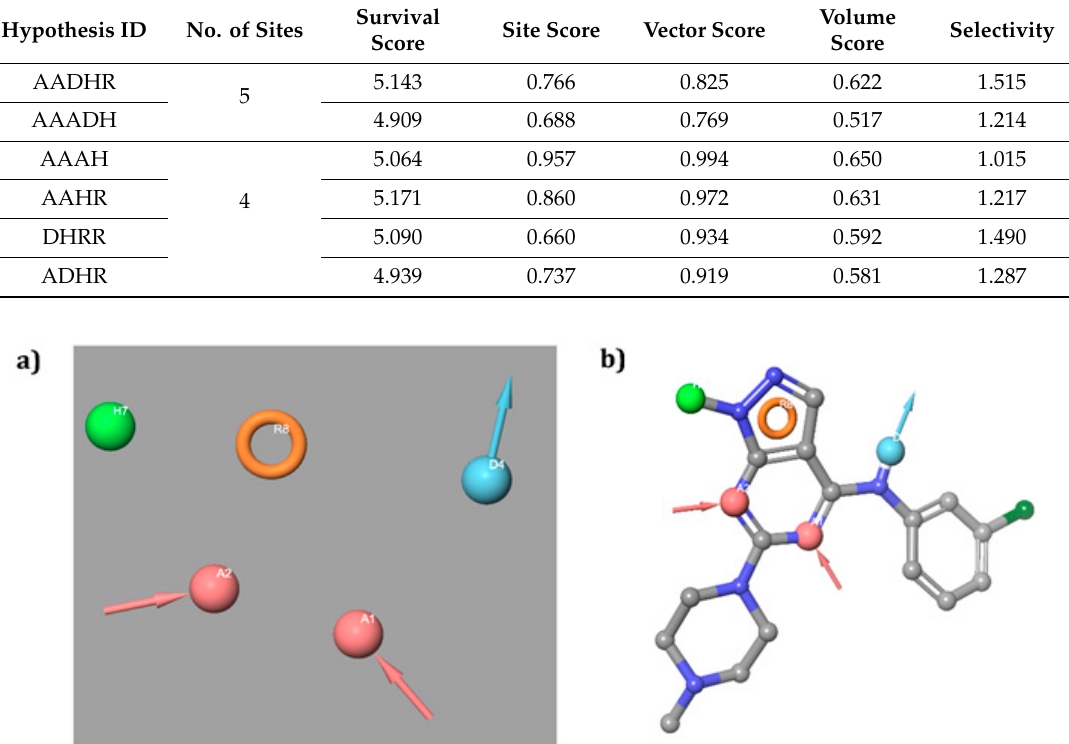
Figure 1. ( a ) Hypothesis AADHR generated from pharmacophore modeling highlighting intra distances; Figure 1. (a ) Hypothesis AADHR generated from pharmacophore modeling highlighting intra ( b ) Alignment of hypothesis against molecule in actives distances; ( b ) Alignment of hypothesis against molecule in actives dataset.